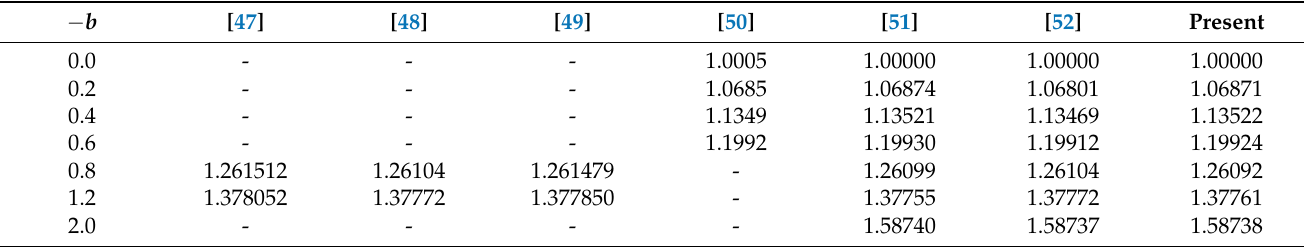
Table 3. Comparisons of the values of − f (cid:48)(cid:48) ( 0 ) obtained via the proposed scheme with existing results [41–46] against various values of b